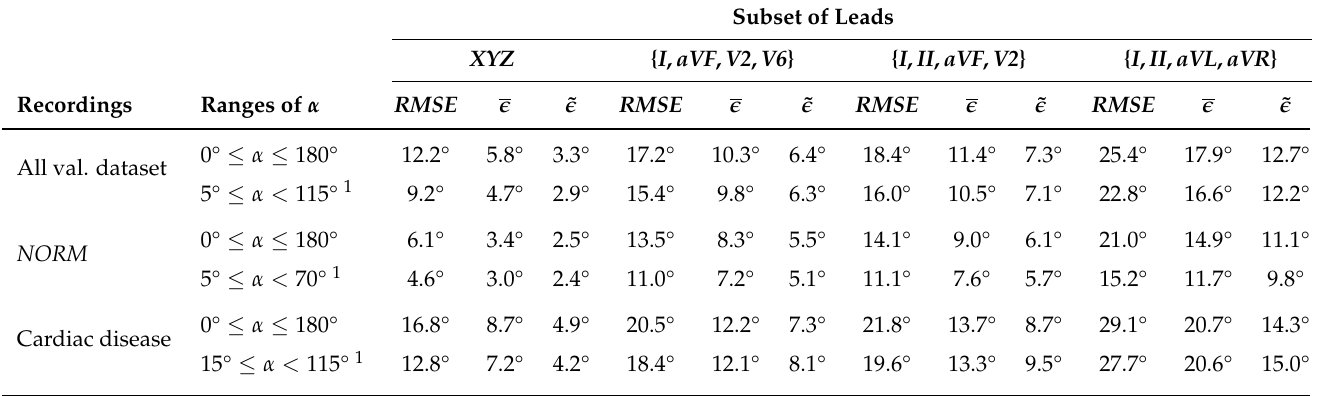
1 Ranges of α adequately represented in the training dataset (>200